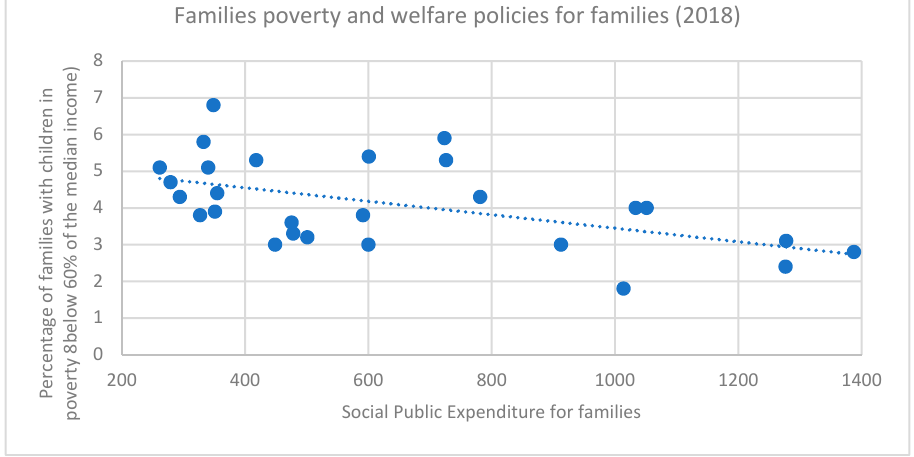
Figure 9. Source: our elaboration on Eurostat data.